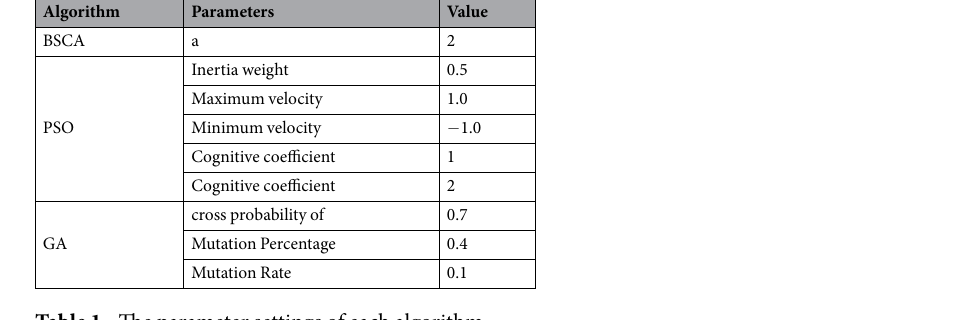
Table 1. The parameter settings of each